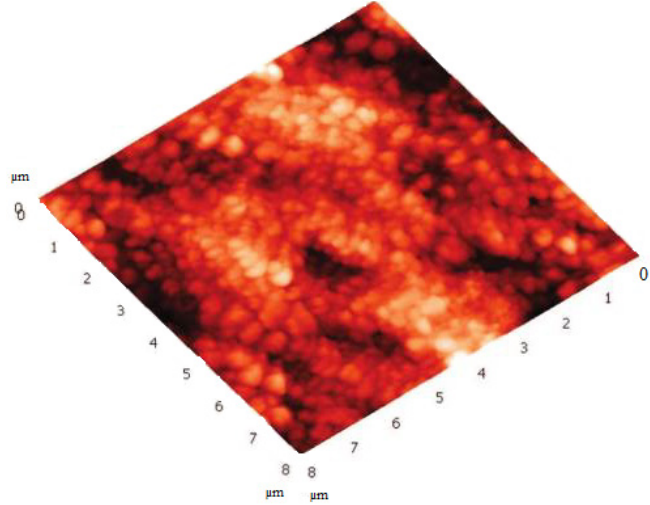
Figure 24. Atomic force micrsocope image of 17 -based SLNs spread on mica and imaged in air in noncontact mode [92].